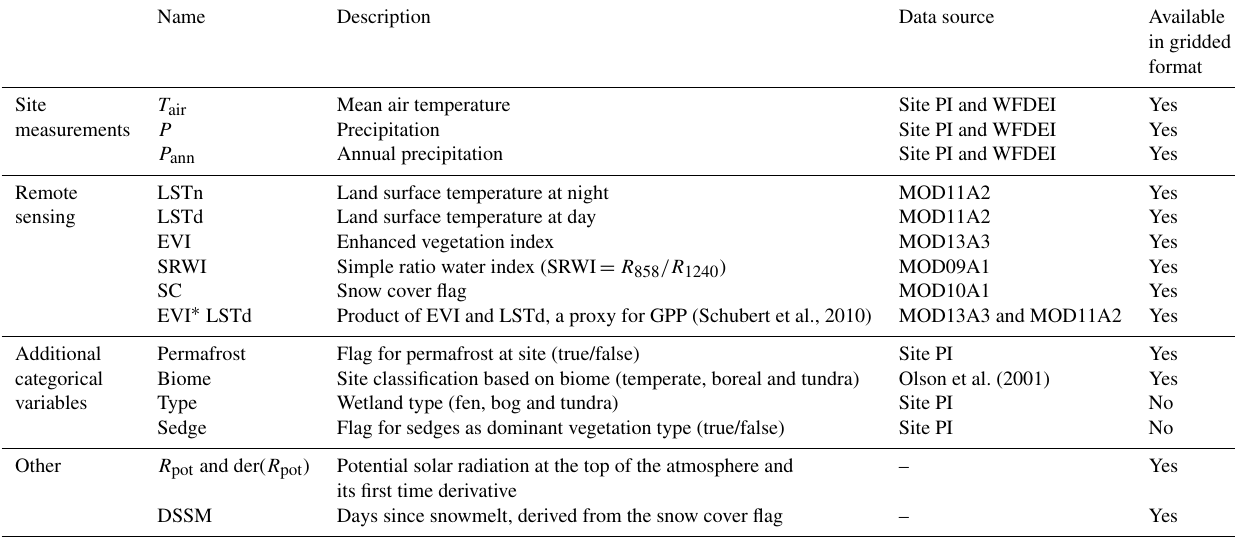
Table 1. Description of input variables for RF model development for upscaling. Data were aggregated to monthly values (see text) unless otherwise noted